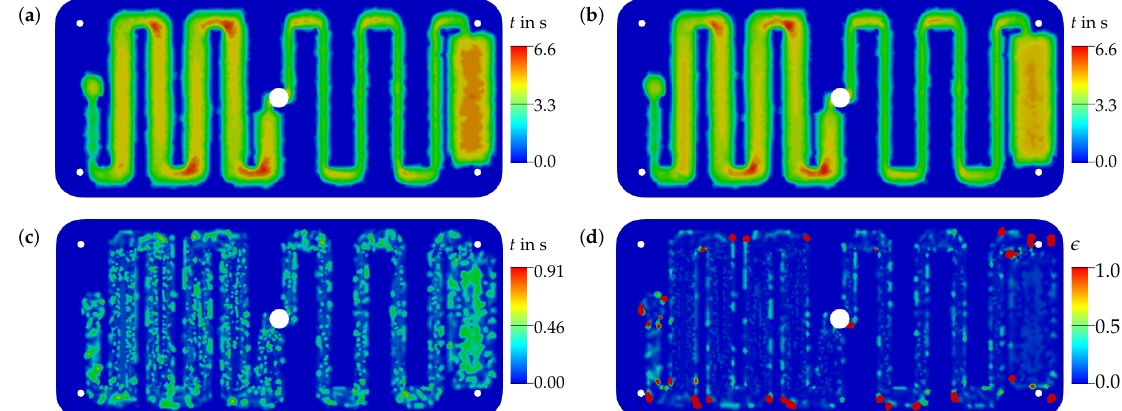
Figure 7. Comparison of t m for sample 52. ( a ) Numerical result of full-scale simulation; ( b ) predicted result by Random Forest; ( c ) absolute difference; ( d ) relative error (values with error > 1 are indicated by the color red).